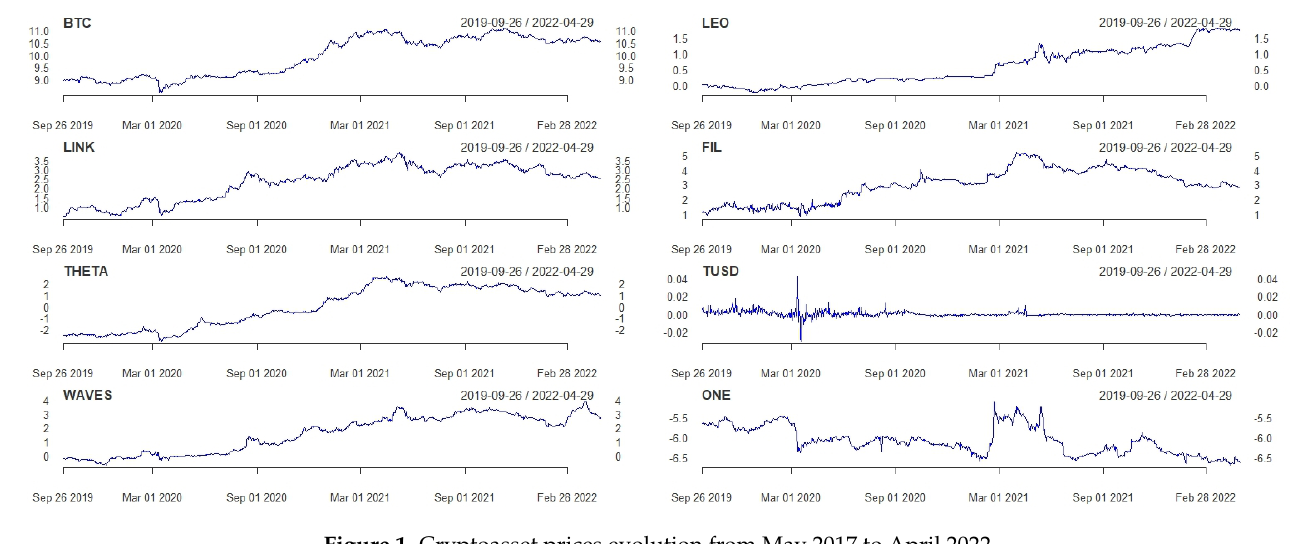
Figure 1. Cryptoasset prices evolution from May 2017 to April 2022.